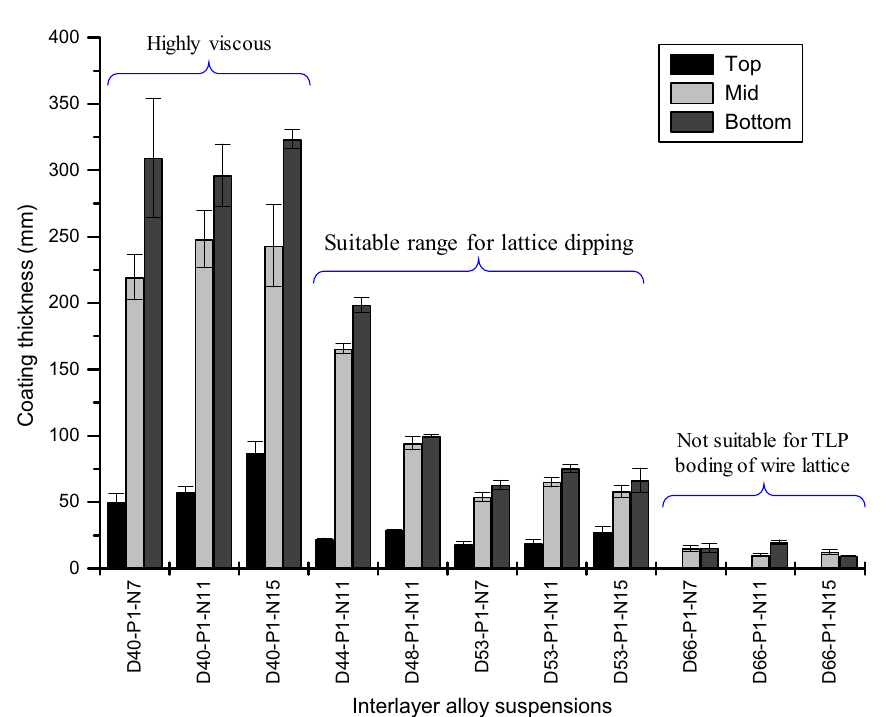
Figure 15. Coating thickness at three different locations (top, mid, and bottom) of the wire specimens dipped into the prepared interlayer alloy